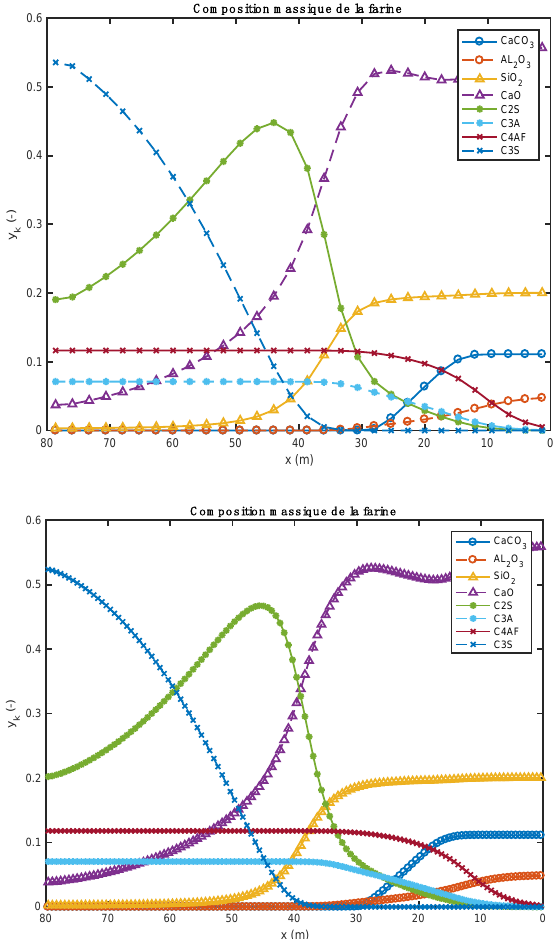
Figure 7. Comparison of the meal composition profiles obtained with 30 (above) et 120 (below) compute nodes (heavy fuel oil and biomass).